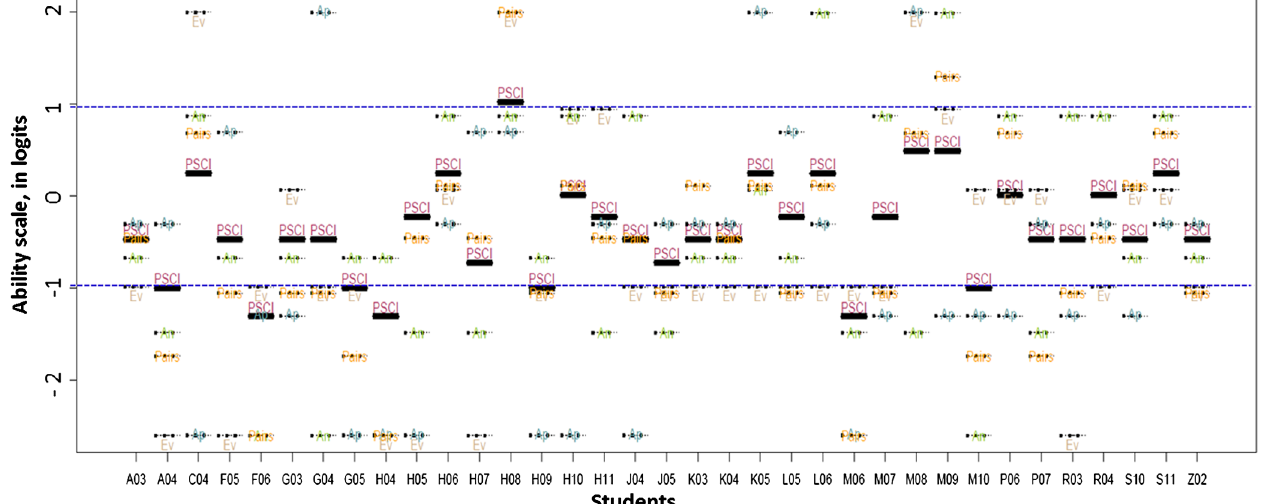
FIG. 10. Ability summary chart. The chart gives the estimated ability parameters for each of the students listed on the horizontal axis. The horizontal broken lines mark the 95% confidence interval around the median of the ability scale. The black thick dashes mark person locations on the full PSCI reference scale. The thin dotted dashes represent the persons ’ locations on the subscales Application (Ap), Analysis (An), Evaluation (Ev), and PAIRS. A location at the top of the chart denotes good command of the concepts and skills addressed by the items in that subset, or high knowledge-coherence if the subset is PAIRS. A location at the bottom of the chart signals lack of appropriate knowledge to solve the items in that subset, or lack of knowledge-coherence if the subset is PAIRS. For the 35 students on this chart, there are numerous locations below the median of the Application-abilities. The instructor could infer that these students are not familiar with the concepts addressed by the set